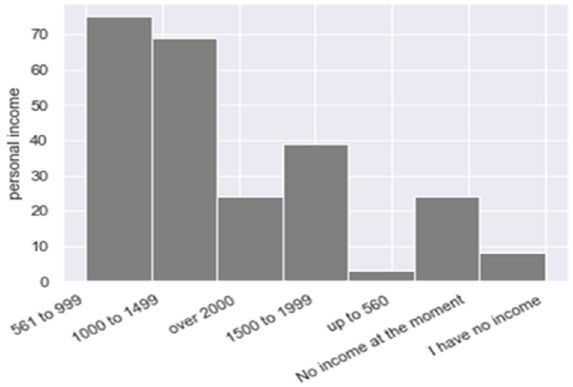
Figure A5. Profile of respondents by personal income. Source: own research.